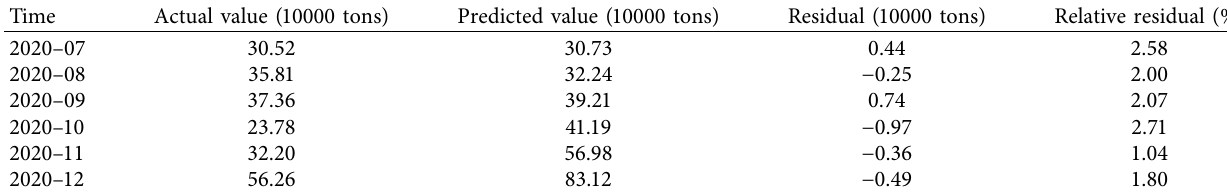
Table 3: Residual data of the cargo throughput.